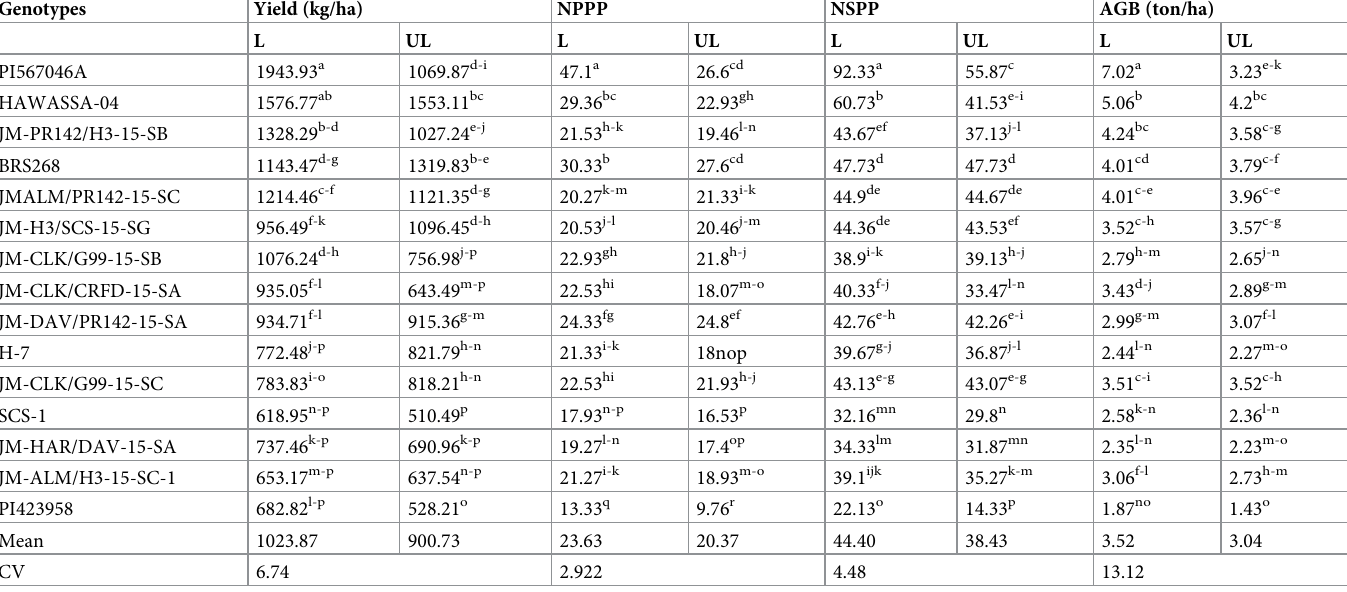
Table 4. Interaction effect of genotypes and lime for yield and yield components of soybean genotypes grown under limed and unlimed soil at Mettu during 2017 main cropping season.